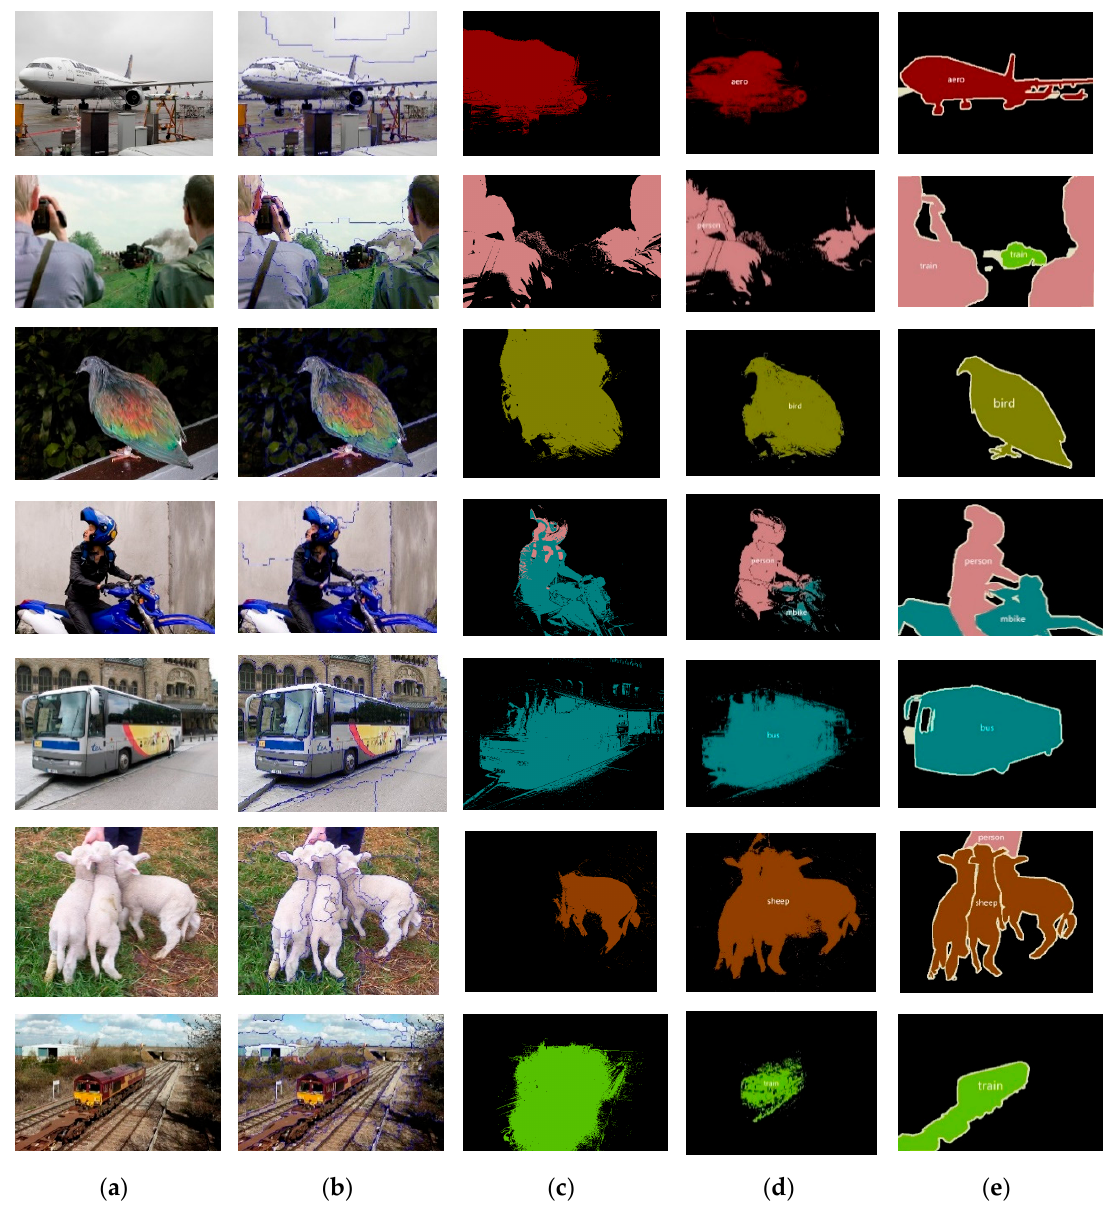
Figure 11. The semantic segmentation obtained by combining region merging and CNN. ( a ) The original images. ( b ) Superpixel region merge results. ( c ) Constrained Convolutional Neural Networks (CCNN). ( d ) RMNN. ( e ) The ground truth. See also Table 1.